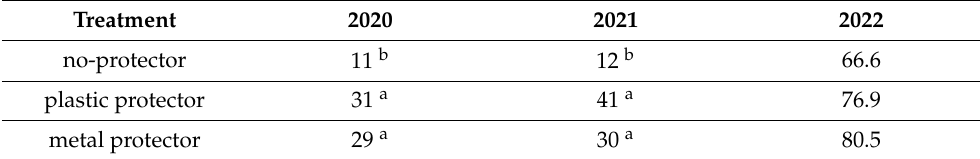
Table 1. Percentage of Artemisia tridentata plants outplanted in October 2019 bearing inflorescence at the end of the 2020, 2021, and 2022 summers. Percentages were calculated based on the number of live plants present during the evaluation of inflorescence occurrence. Values labeled by different letters are significantly different within a column based on χ 2